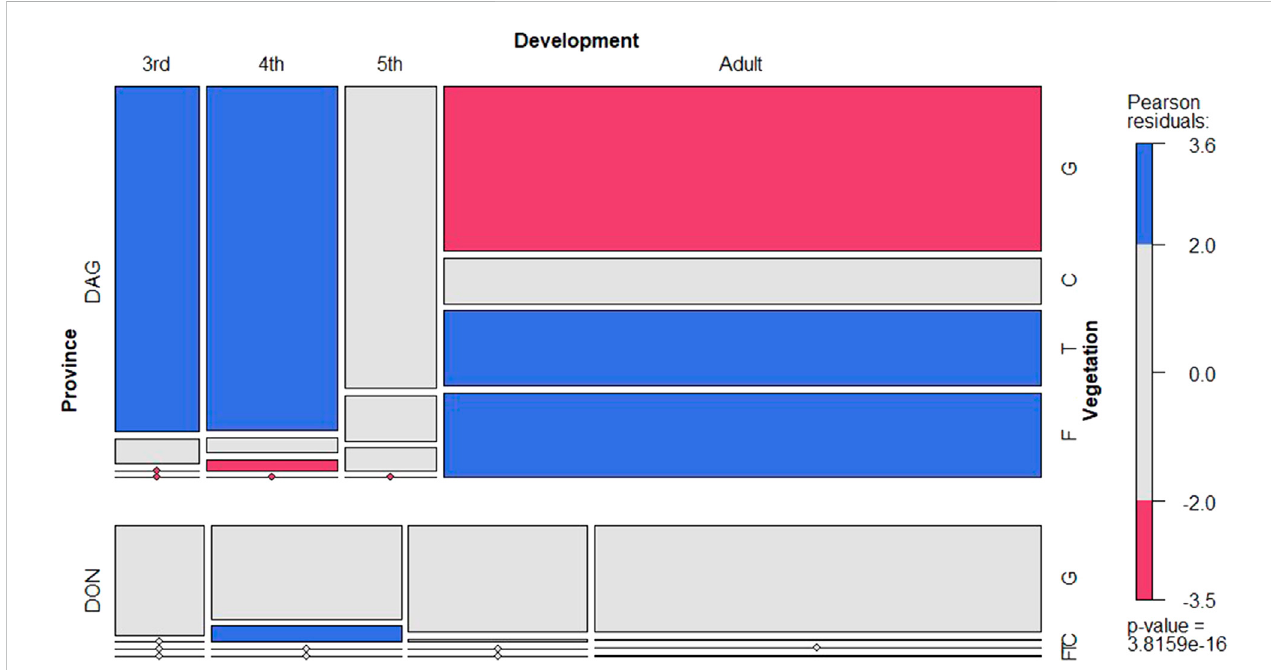
FIGURE 2 Conditional mosaic plot based on the contingency table with the number of locust records in Dagang (top) and Dongying provinces (bottom) per vegetation position(y-axis)anddevelopmentstage(x-axis)indaytime.ThecolorgradientindicatesthePearsonresidualsrepresentingthestandardizeddeviationsoftheobserved frequencies from expectations. The blue and red colors indicate the combination of categories statistically signi fi cant at 95% con fi dence level ( α = 0.05) respectively above and below their expected frequencies. Boxes for the vegetation variable are ordered from ground to fl ying position (G - ground, C- canopy, T-top and F- fl ying). The p -value at the right bottom corner indicates the χ 2 test of independence, based on the permutation